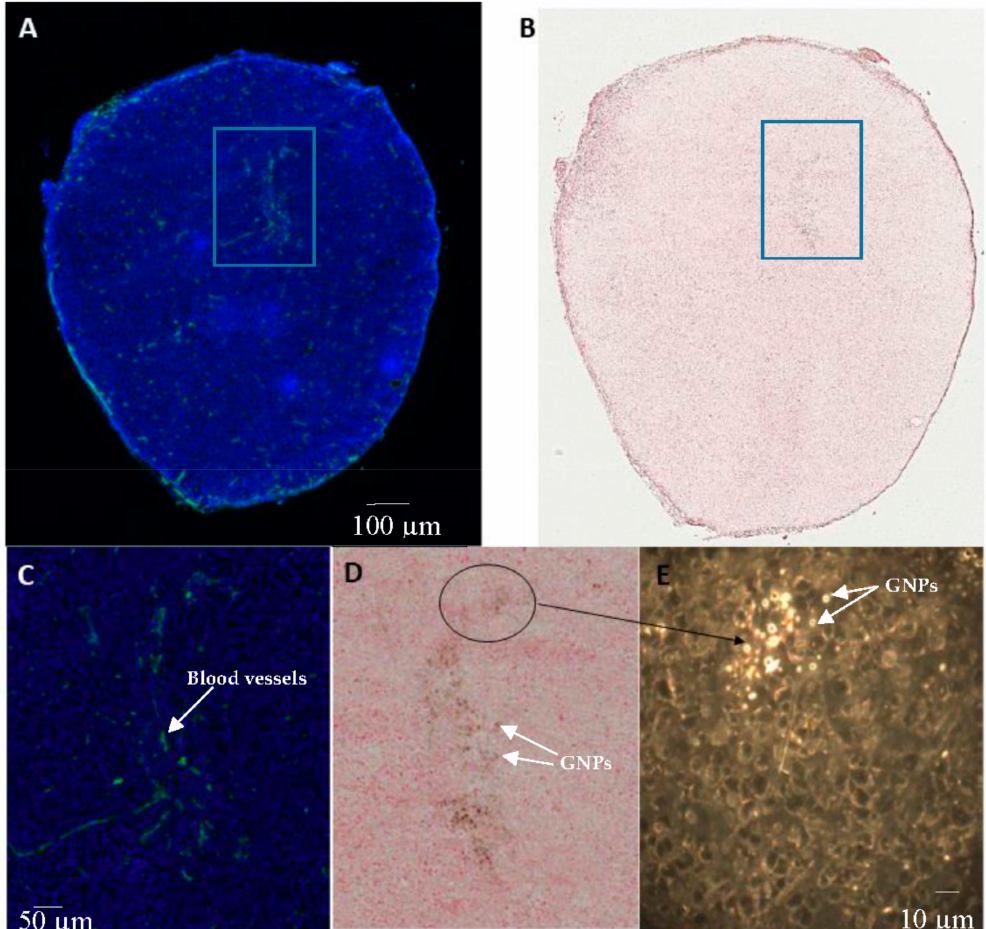
Figure 8. GNP accumulation in a tumor: ( A ) section of tumor with cell nucleus stained with DAPI (blue) and blood vessels marked with CD31 (shown in green); ( B ) silver stained GNPs (shown in black) accumulated in an eosin stained section of tumor; ( C ) magnified image of ( A ); ( D ) magnified image of ( B ); ( E ) dark field image corresponding to ( D